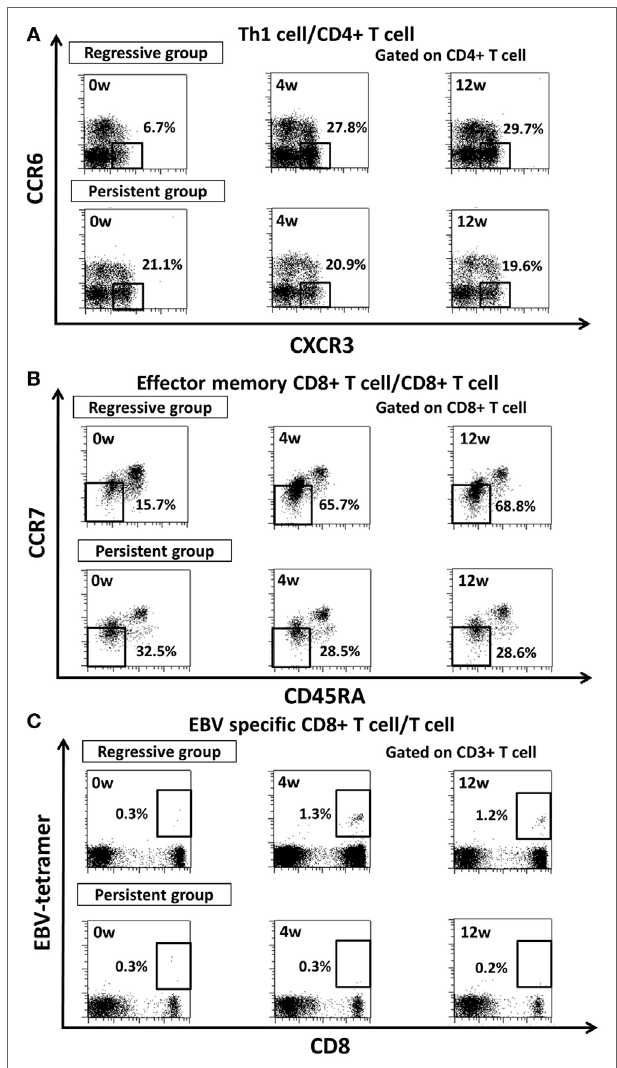
Figure 4 | Representative figure for transition of proportion of (a) Th1 cell, (B) effector memory CD8 + T cell, (c) EBV-specific CD8 + T cells after methotrexate cessation in regressive group and persistent group. Th1, T helper 1; EM, effector memory; EBV, Epstein–Barr